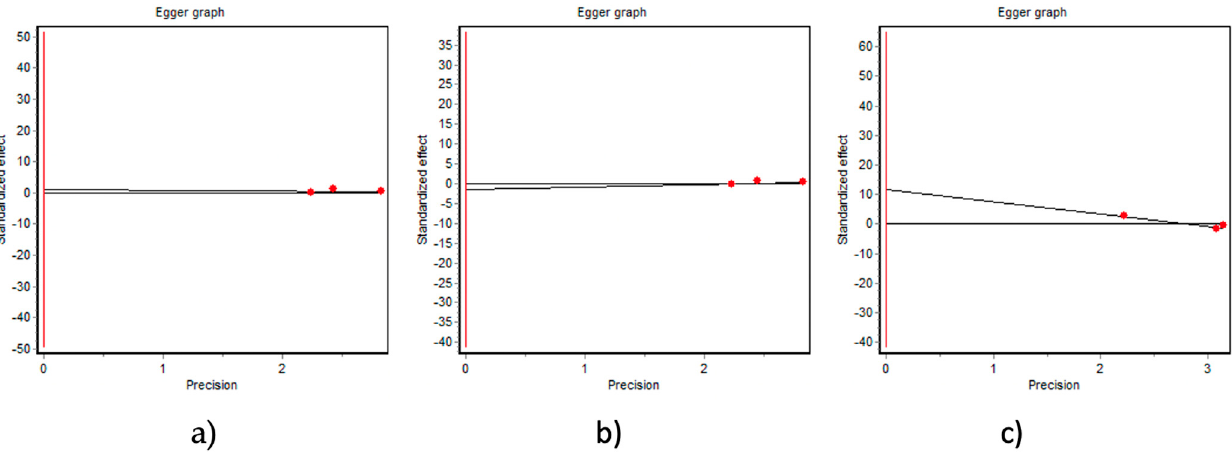
Figure 6. Egger graph to show the risk of bias in the analyzed study: ( a ) CAL gain in Er:YAG laser group ( p = 0.82), ( b ) PPD reduction in Er:YAG laser group ( p = 0.69) and ( c ) PPD reduction in diode laser group ( p = 0.22).